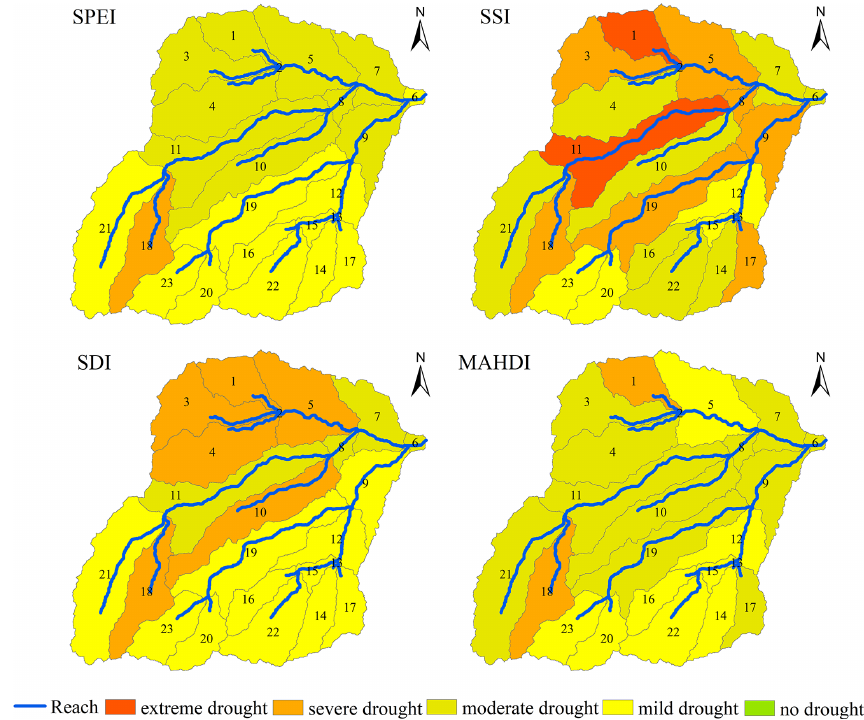
Figure 6. Distribution of SDI, SSI, SPEI and MAHDI at a 12-month scale in JRB in